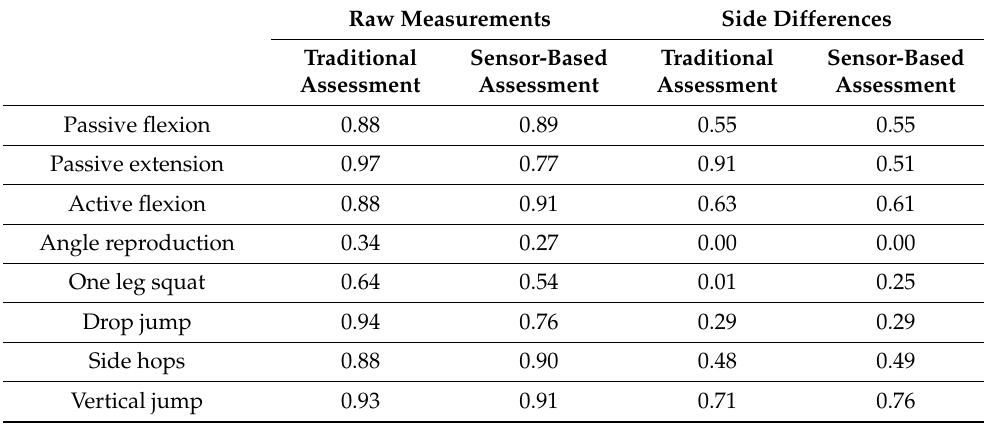
Table 5. Reproducibility of raw measurements and side differences assessed by ICC